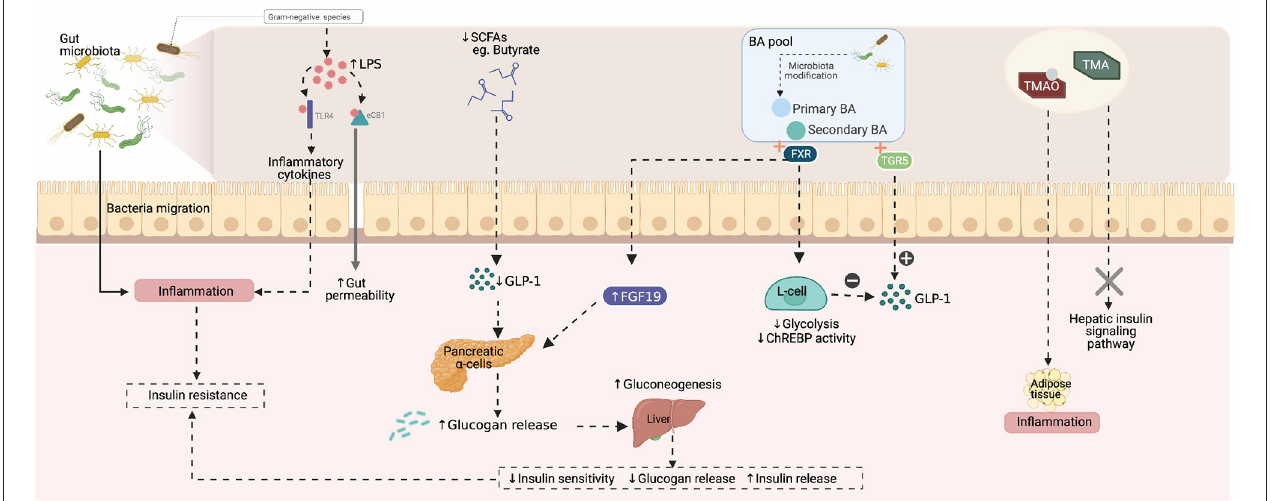
FIGURE 1 | The possible relationship between gut microbiota and pre-diabetes. (Created with BioRender.com).